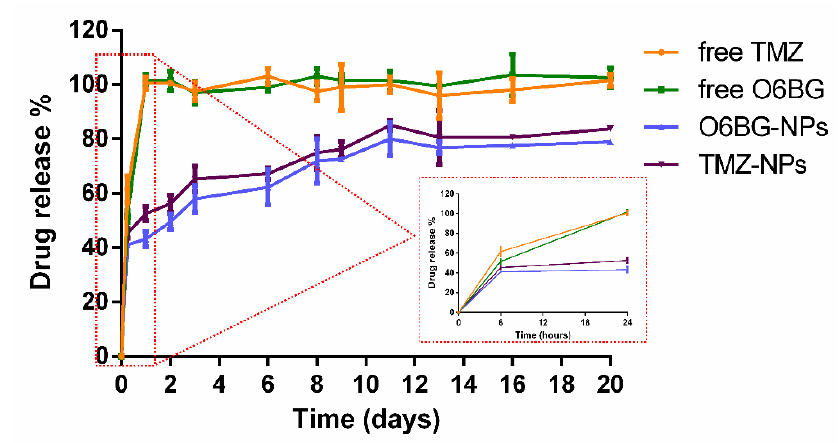
Figure 9. In vitro release of TMZ and O6BG from PLGA NPs in PBS (10 mM, pH 7.4) at 37 °C. Free TMZ and O6BG were used as control. Results are given as mean ± SD ( n = 3 ). An enlargement of the first time points—6 and 24 h—is presented to highlight the burst effect.